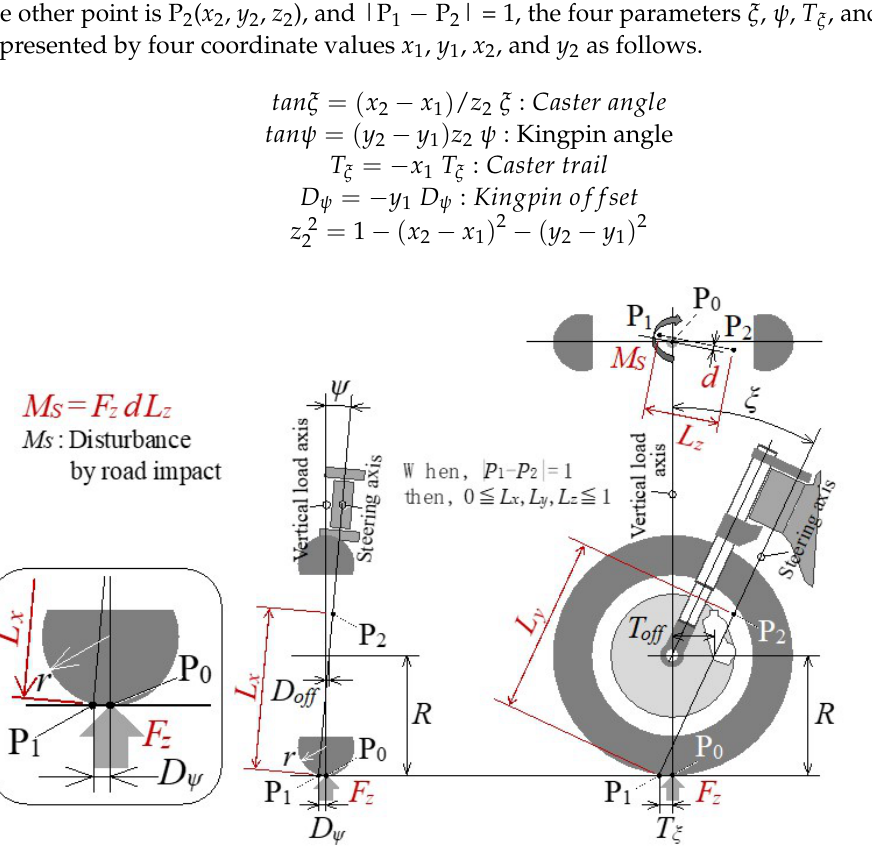
Figure 8. Steering moment disturbance ( M S ) by road impact ( F z